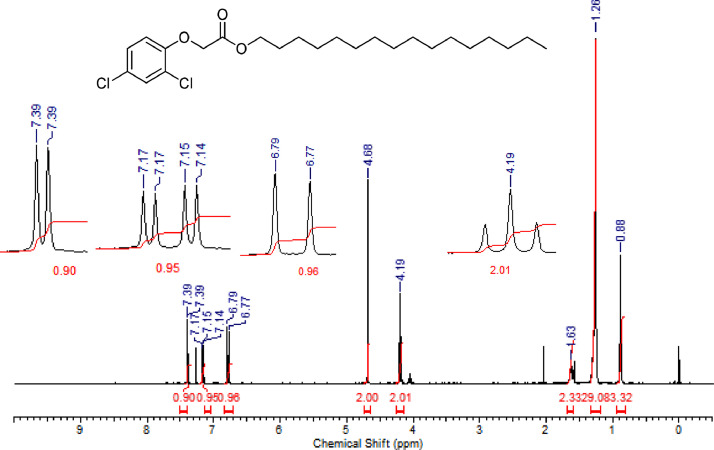
1H NMR (CDCl3, 400 MHz) spectrum of compound 6a.